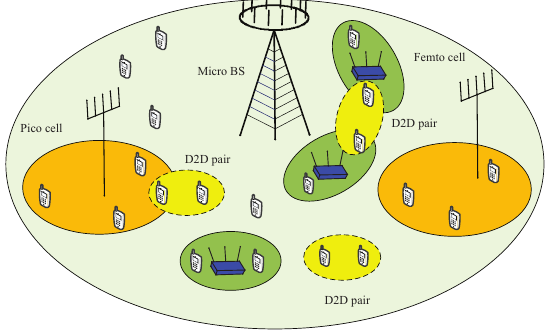
Figure 1. Illustration of the considered heterogeneous network.